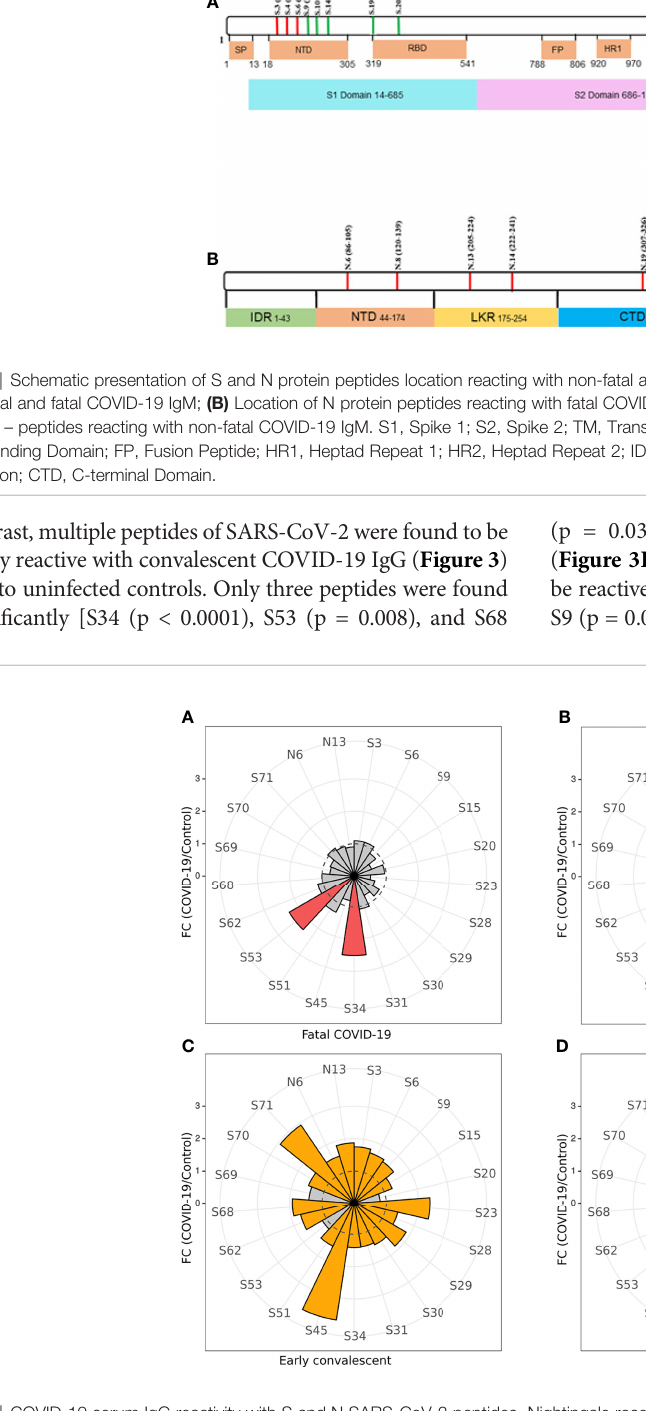
FIGURE 3 | COVID-19 serum IgG reactivity with S and N SARS-CoV-2 peptides. Nightingale rose plots demonstrating reactivity of acute (non-fatal and fatal) COVID-19 and convalescent serum (early and late convalescent) with SARS-CoV-2 S and N peptides. IgG reactivity with SARS-CoV-2 S and N protein peptides was analyzed using ELISA. (A) IgM reactivity with S and N SARS-CoV-2 peptides in fatal COVID-19; (B) IgM reactivity with S and N SARS-CoV-2 peptides in non-fatal COVID-19; (C) IgM reactivity with S and N SARS-CoV-2 peptides in early convalescent COVID-19; (D) IgM reactivity with S and N SARS-CoV-2 peptides in late convalescent COVID-19. Red, blue, orange and yellow – statistically signi fi cant IgG reactivity in COVID-19 as compared to control (p < 0.05, Kruskal-Wallis test with BH adjustment). Data is presented as fold change – mean value of reactivity to peptide in COVID-19 divided by mean of reactivity to the same peptides in control.